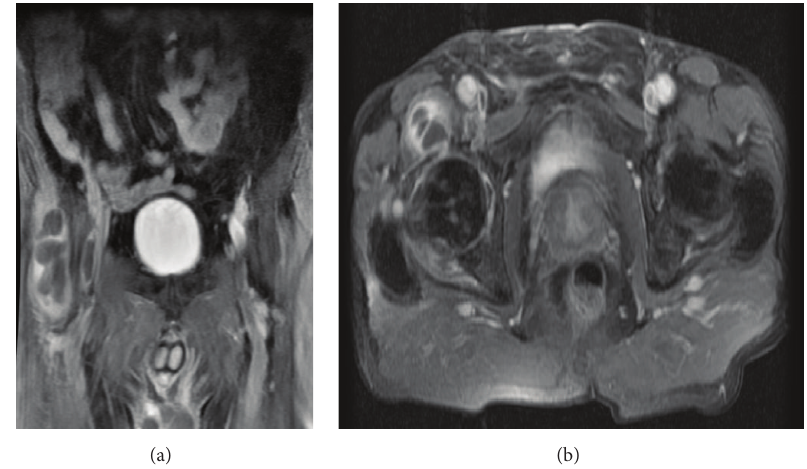
Figure 3: MRI with contrast. The MRI sequences with contrast medium confirm the predominantly fluid content of the neoformation, with contrast enhancement of the peripheral portion and the septa. Synovitis of the right hip is detectable. (a) Coronal postcontrast T1-weighted MR image with fat saturation. (b) Axial postcontrast T1-weighted MR image with fat